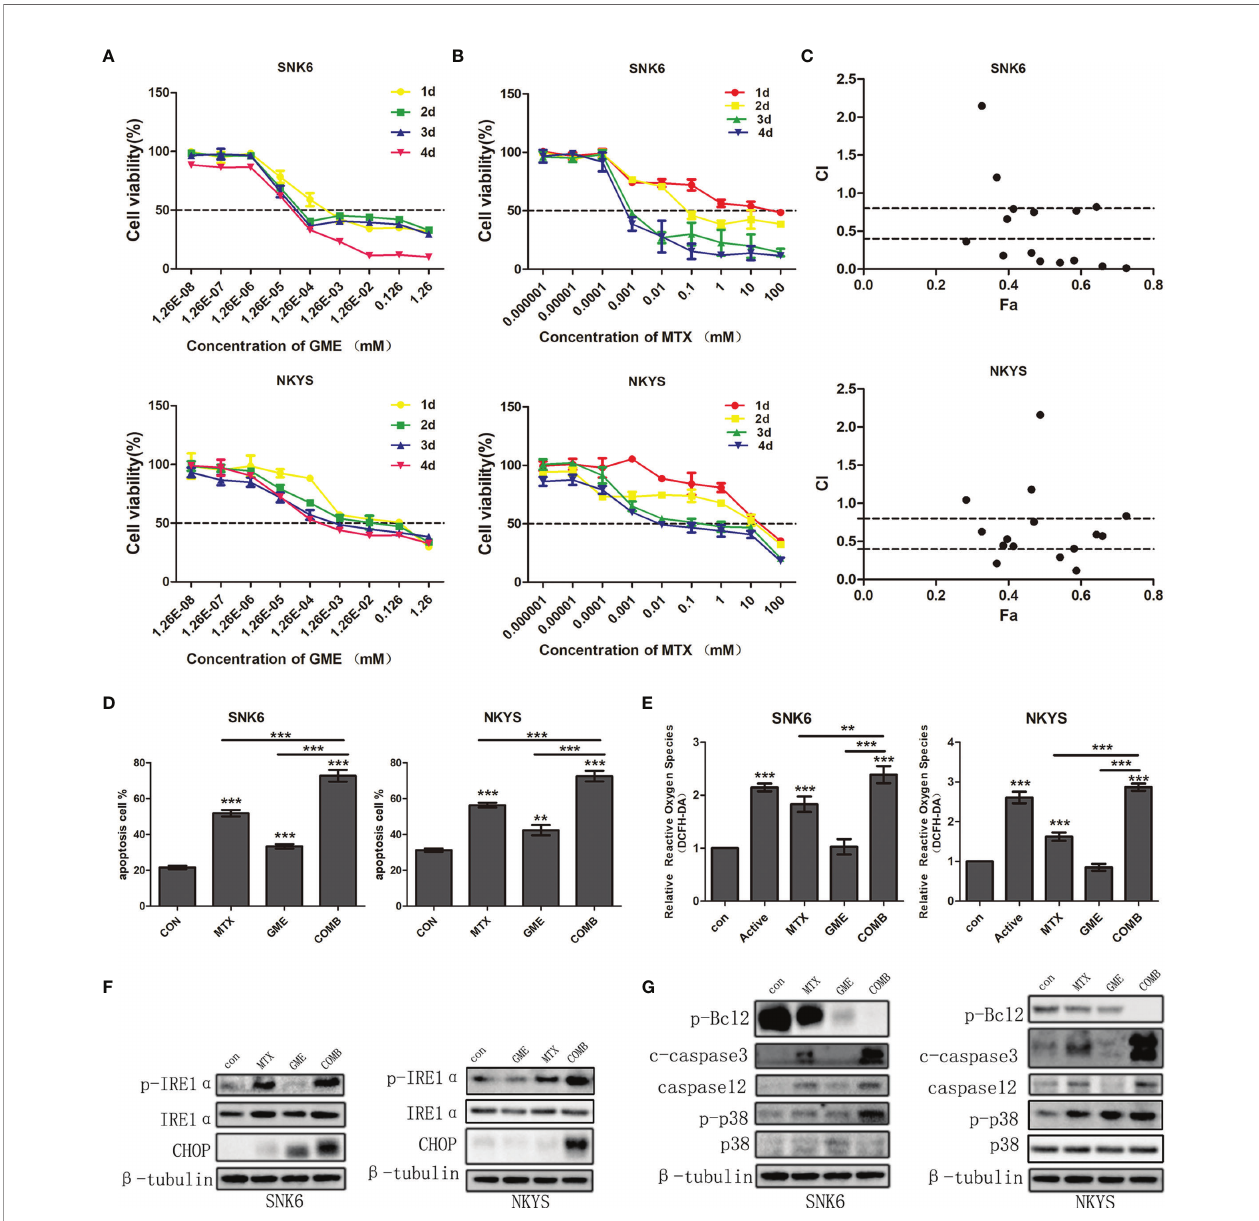
FIGURE 3 | The synergistic effects of HD-MTX and gemcitabine-induced NK/T-cell lymphoma cell apoptosis through ER stress. (A, B) the effects on NK/T-cell lymphoma cell growth of MTX or gemcitabine. (C) the synergistic effects of HD-MTX combined to gemcitabine calculated using CalcuSyn. (D) cell apoptosis was performed followed by fl ow cytometric analysis. (E) intracellular ROS was measured by the MFI of DCFH-DA. (F, G) the ER stress and apoptosis-related markers were detected by western blotting. ** means P < 0.01, *** means P <